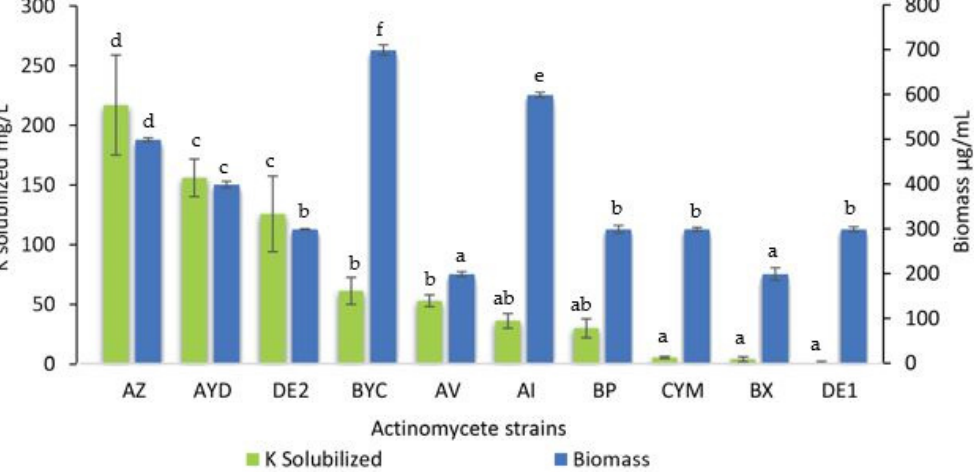
Figure 3. Concentration of soluble potassium released (mg/L) from orthoclase in the supernatant of cultures of the ten selected Actinomycete strains (green bars) grown for five days in AMM containing 2 g/L orthoclase with values subtracted from those of the non-inoculated flasks. The maximal biomass yield in µg/mL of the 10 selected Actinomycete strains is shown in the histogram (blue bars). Error bars represent standard deviations of the mean values of the results of three independent culture replicates. Different lowercase letters above bars show significant differences between treatments at p ≤ 0.05.